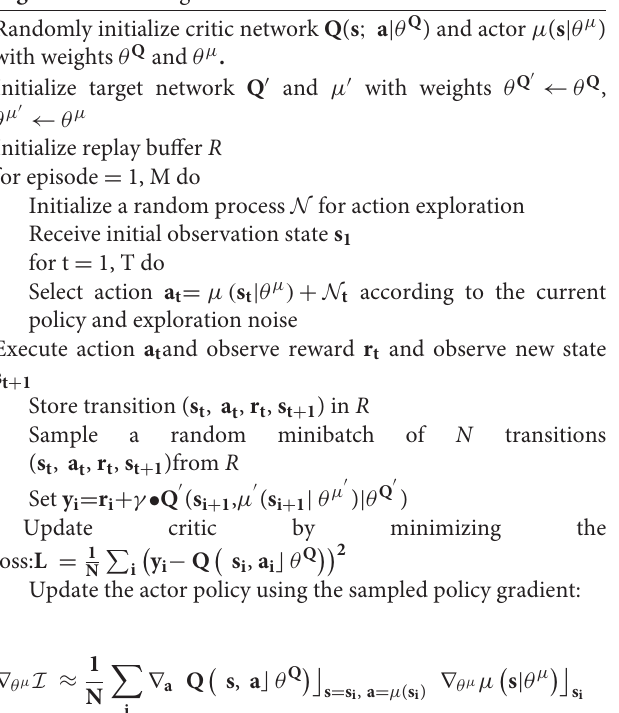
Algorithm 1 The algorithm of